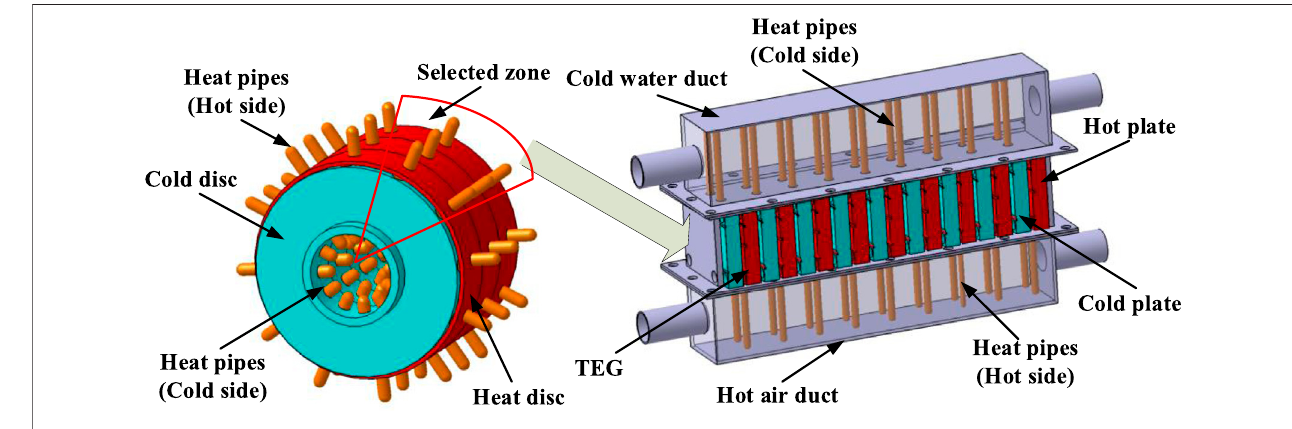
FIGURE 1 | TEG device similar conversion.